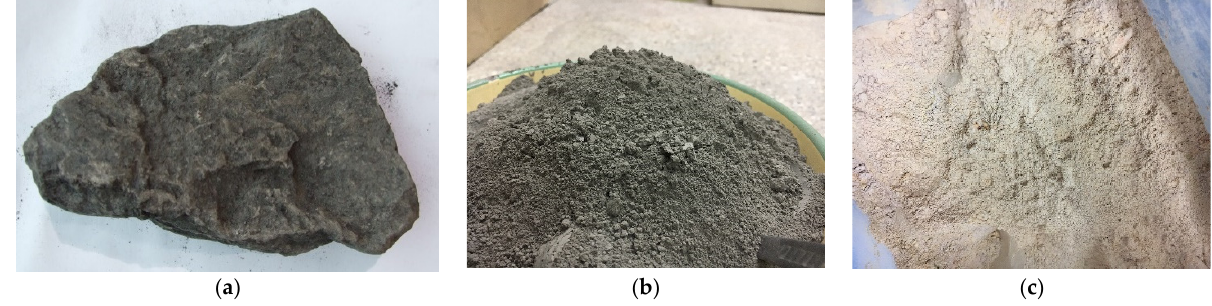
Figure 4. Coal shale used in the study: ( a ) in raw form; ( b ) after mechanical treatment—crushing and grinding; ( c ) after calcination. Table 1. Petrographic composition of the material used in the tests.